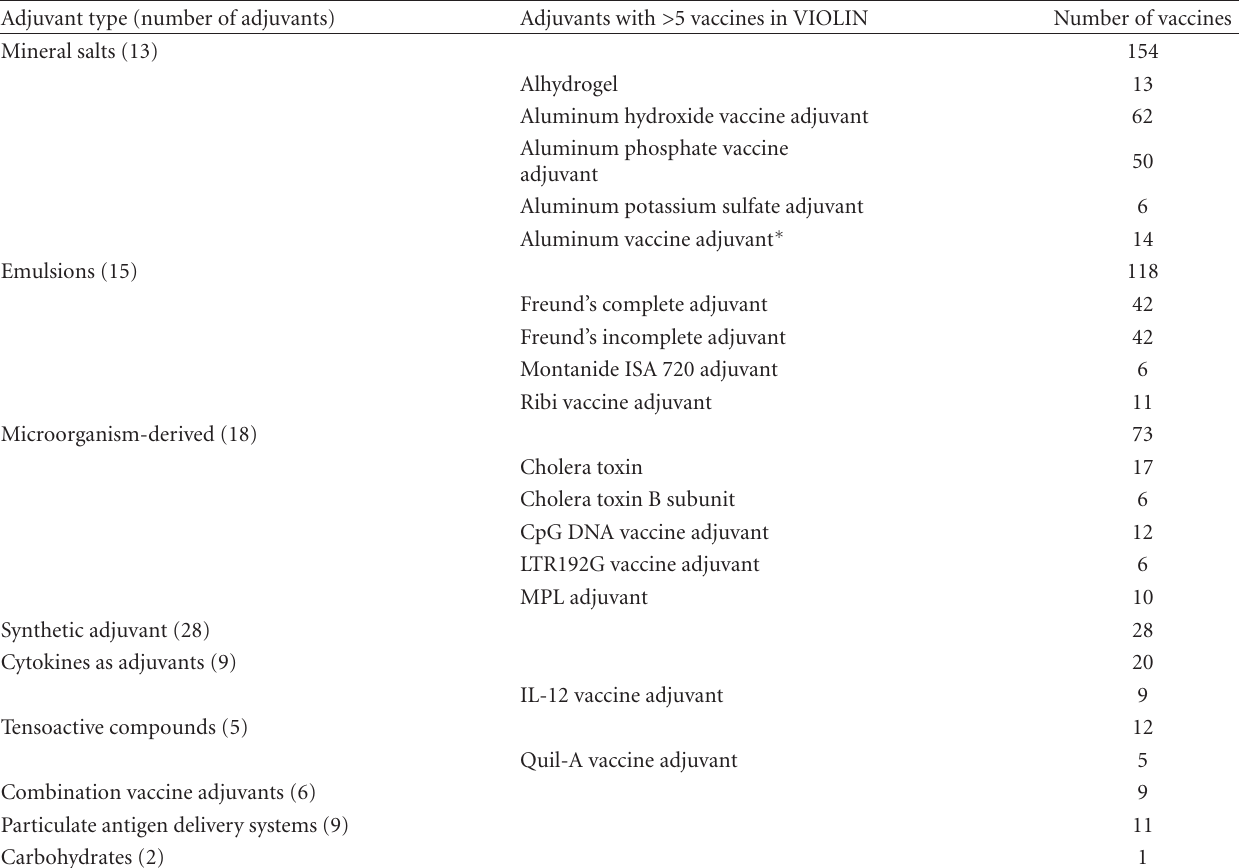
Table 1: Curated vaccine adjuvants used in at least five vaccines curated in